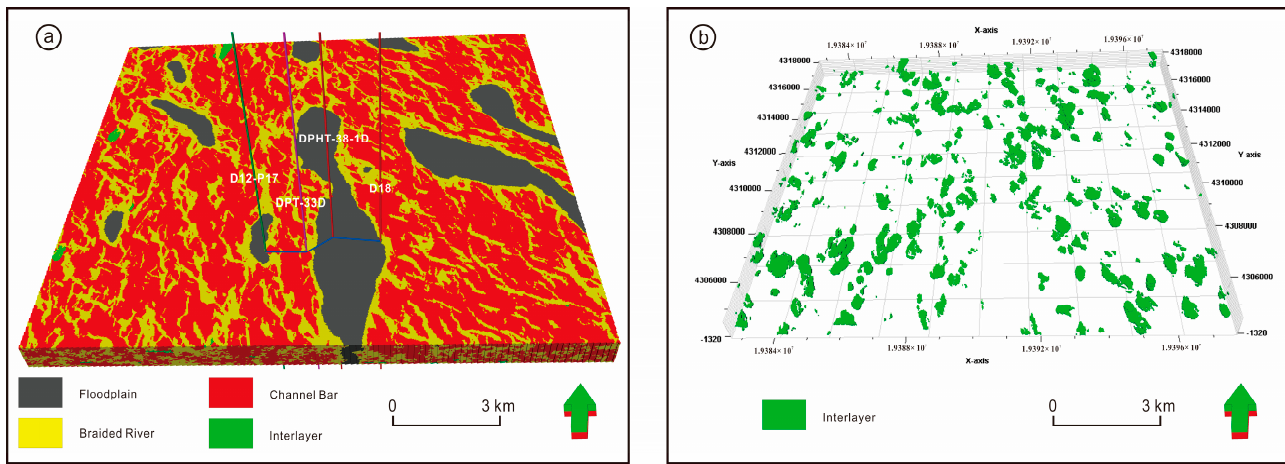
Figure 11. Third hierarchical simulation results. ( a ) Third hierarchical multiple-point geostatistical simulation results in MPS-3 based on 5–3 level architecture units. ( b ) Filter display of interlayer in MPS-3.